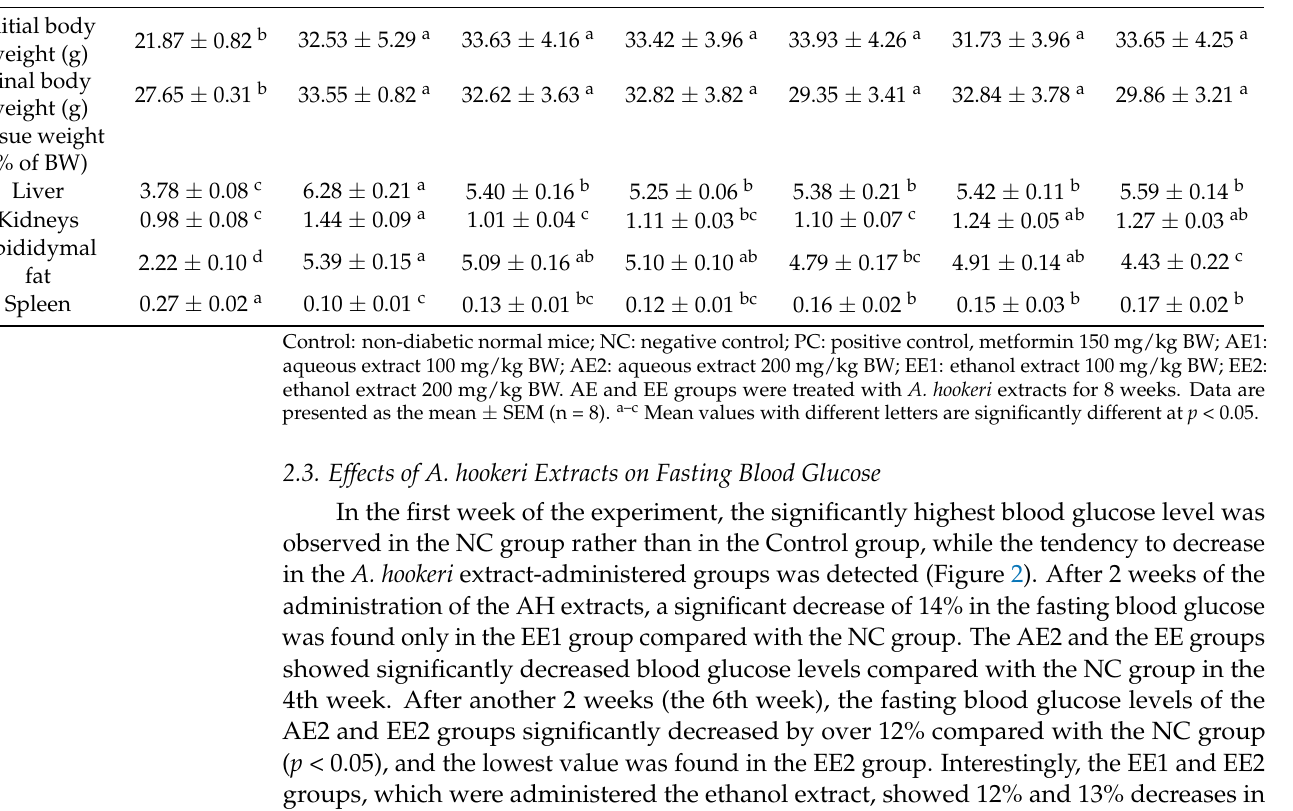
Table 1. Effects of A. hookeri extracts on body and organ/tissue weights of the diabetic mice. Control